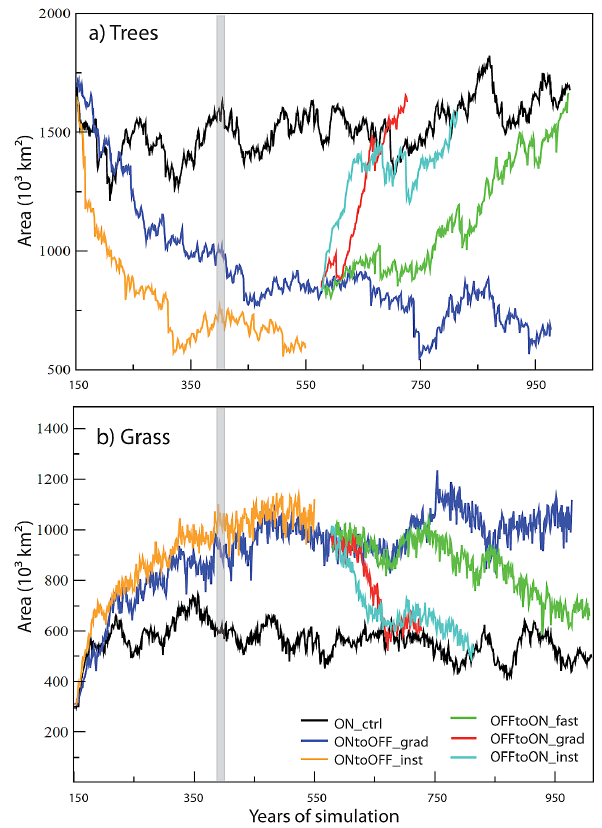
Fig. 12. Area of Western Europe (lat=32/60 ◦ , lon= − 15/20 ◦ ) occupied by (a) tree PFTs and (b) grass in ON ctrl (black), ONtoOFF grad (blue), ONtoOFF inst (orange), OFFtoON grad (green), OFFtoON fast (red), OFFtoON inst (turquoise). The ver- tical grey bars indicate when the AMOC is fully collapsed in ON- toOFF